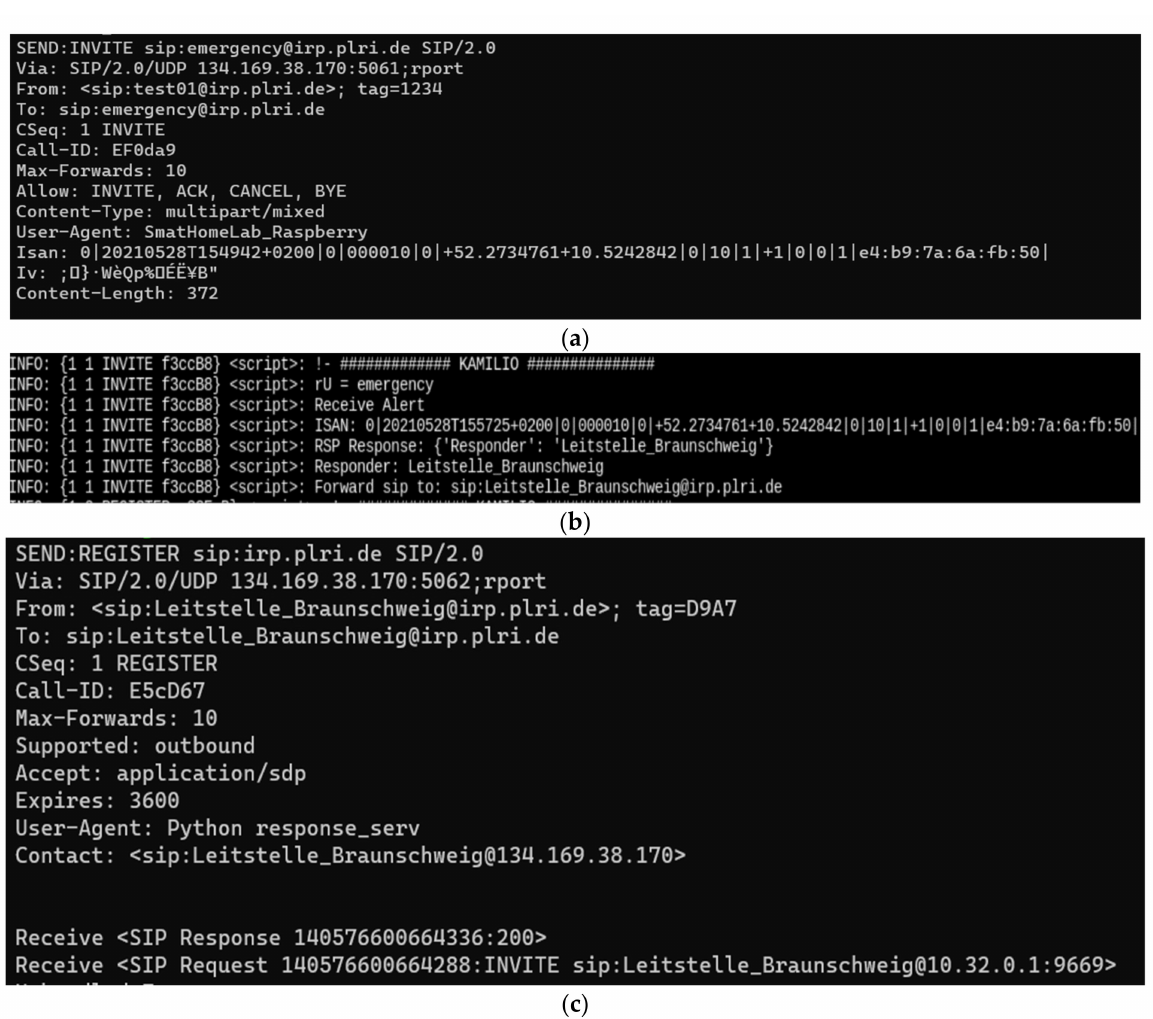
Figure 5. Logs from ISAN system communication with the alerting system ( a ), internal communication ( b ), and the responding system ( c ) to receive, process, and transfer the ISAN upon an emergency,